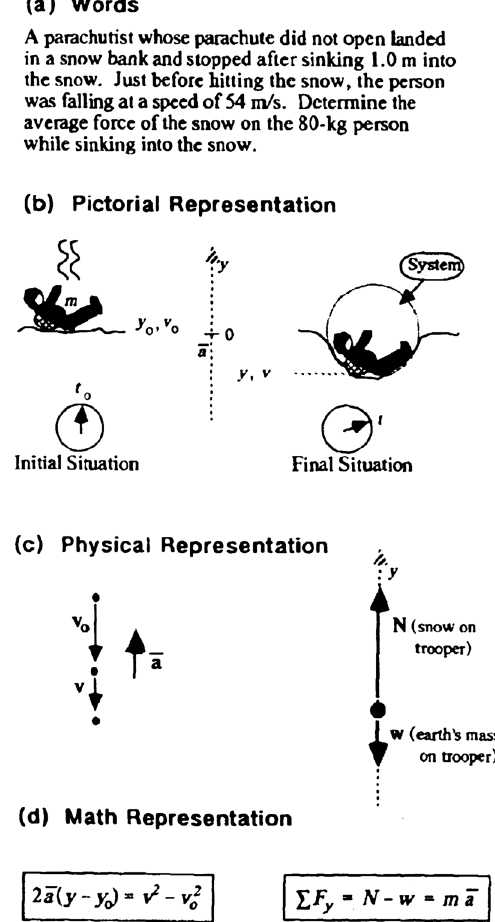
FIG. 1. An example of the need for different representations with different disciplinary affordances for solving a